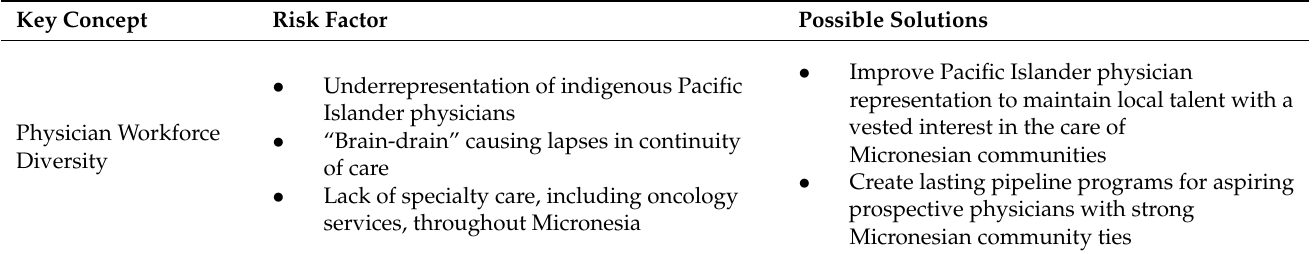
Table 8. Risk factors and possible solutions for physician workforce diversity related to Micronesians with respect to